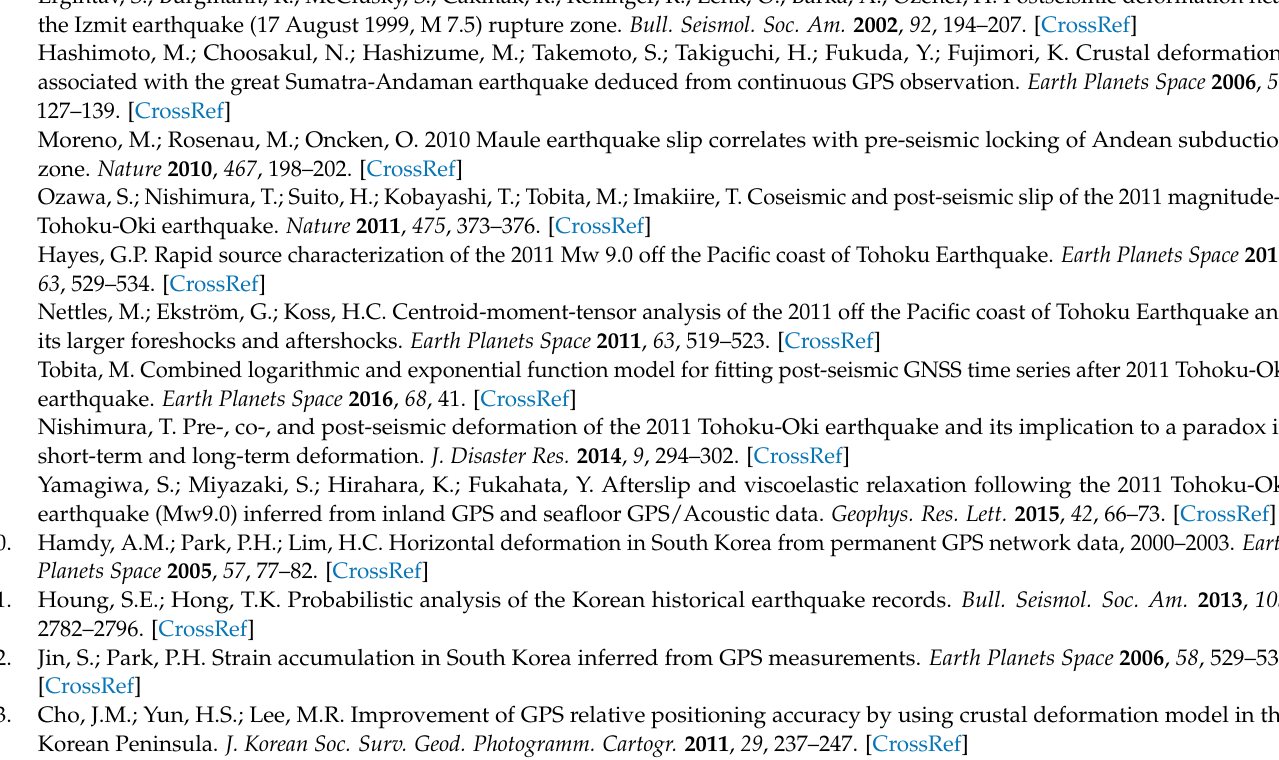
Table S1: Velocity magnitude and direction for all stations in the five periods, Table S2: Post-seismic relaxation completeness, Table S3: Average velocity magnitude and direction for all stations in area ‘A’ with a thin crust, Table S4: Average velocity magnitude and direction for all stations in area ‘B’ with a thick crust, Table S5: Post-seismic relaxation completeness of stations in the crustal thin and thick